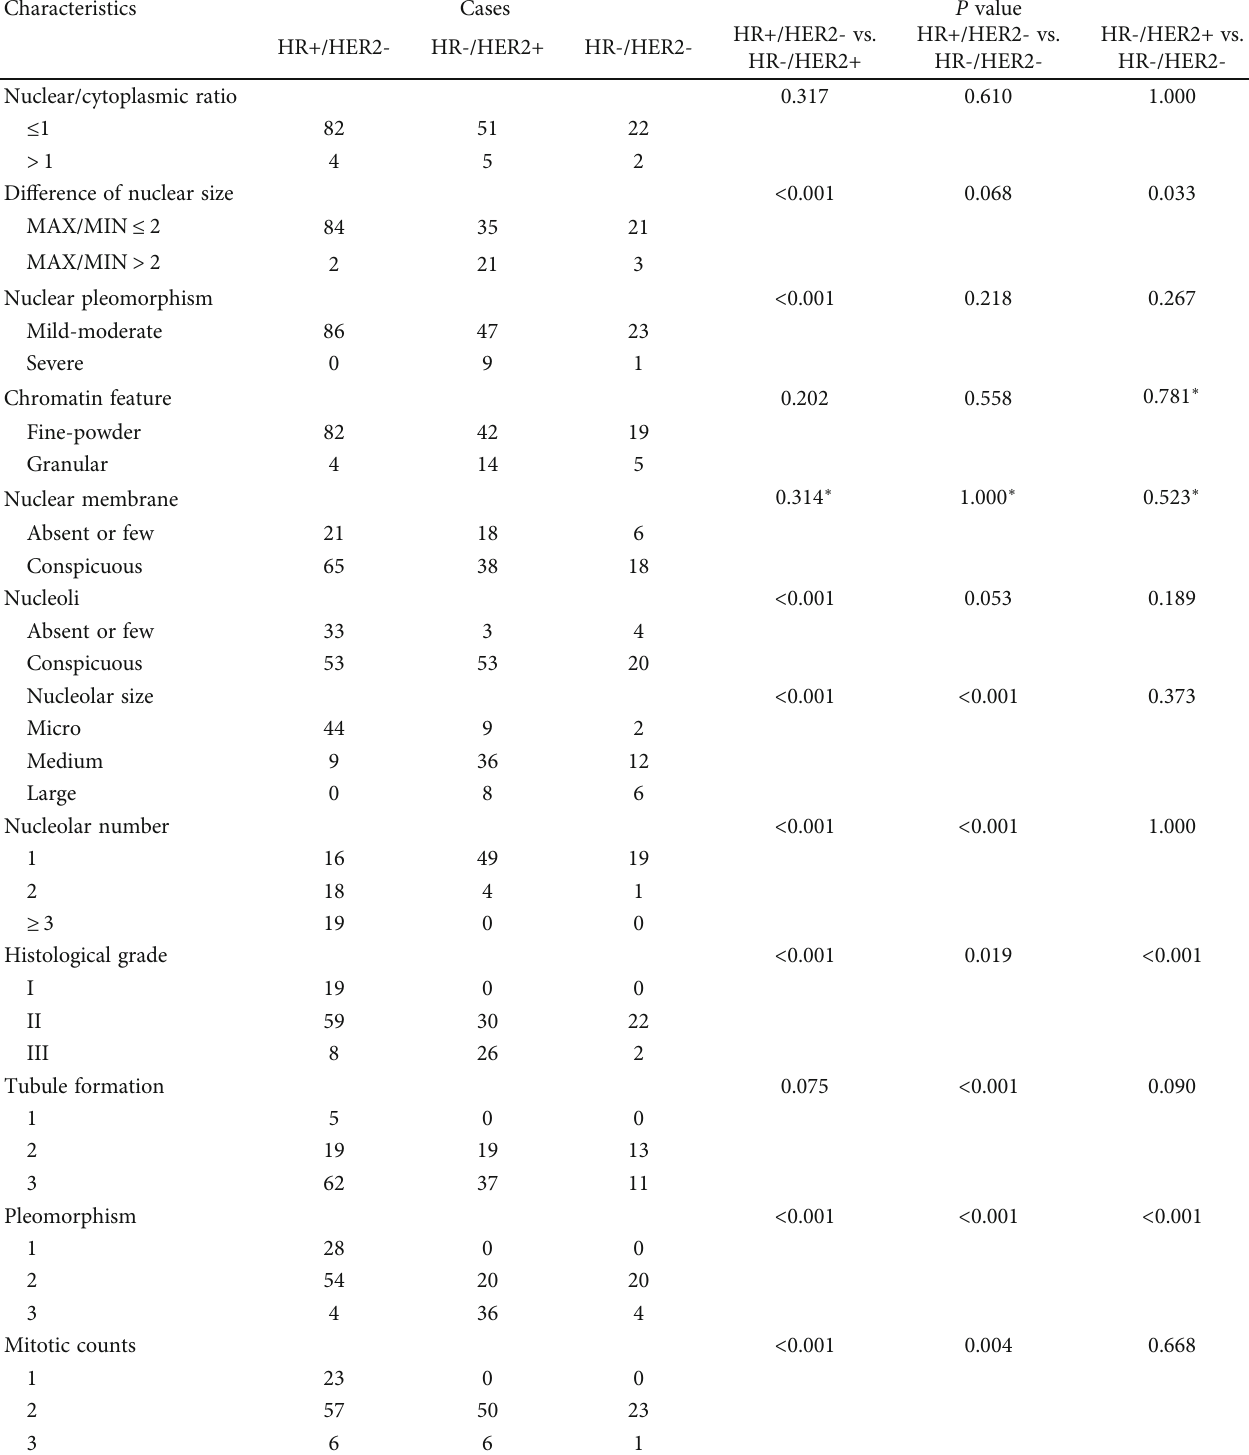
Table 2: Nuclear morphological characteristics of the invasive breast cancer with three